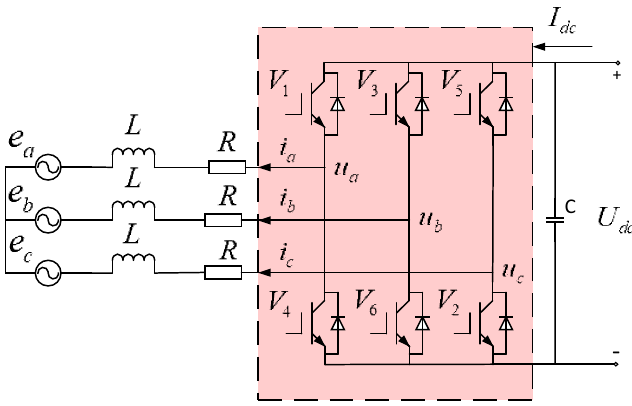
Figure 2. Main circuit topology diagram of grid side converter.